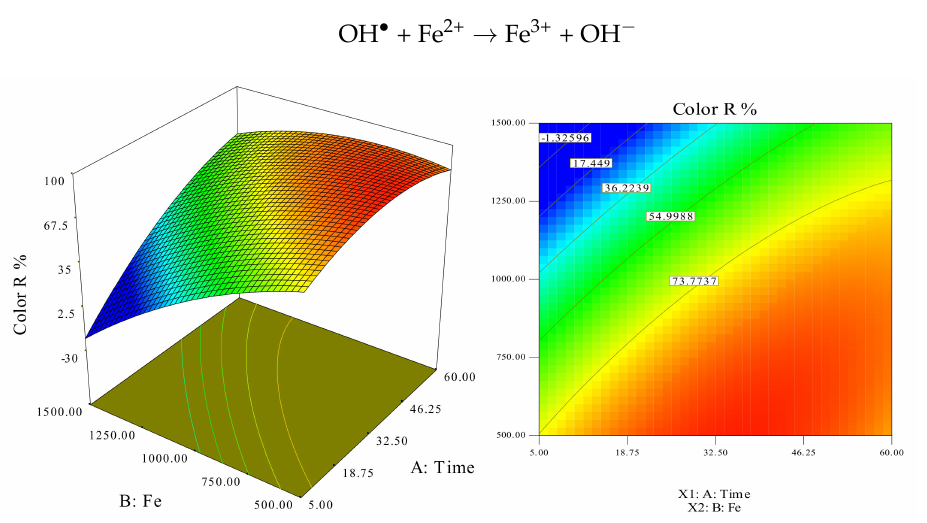
Figure 5. Role of reaction time and Fe 2+ concentration in leachate decolorization depicted in 3D response surfaces and contour